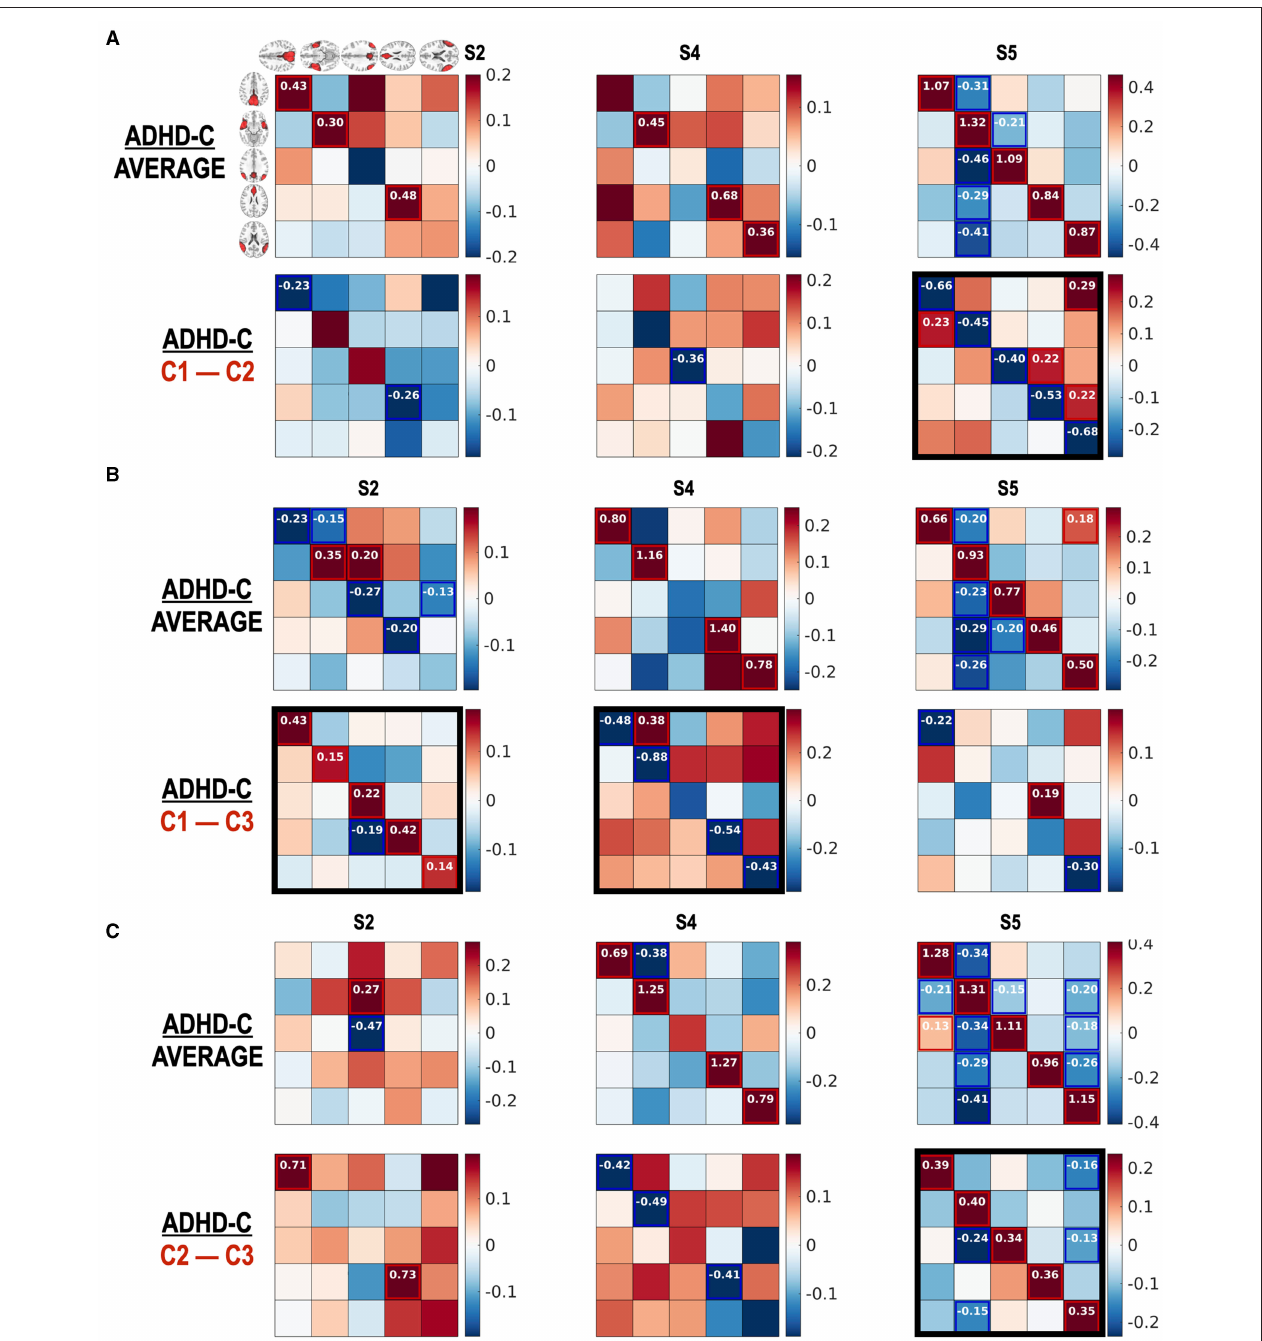
FIGURE 9 | (A–C) Subtype-dependent effective connectivity differences in ADHD-C. According to functional connectivity states, children with ADHD-C have different effective connectivity, in particular between subtype groups C2 and C3 in state 5. See black rectangles that show obvious subtype